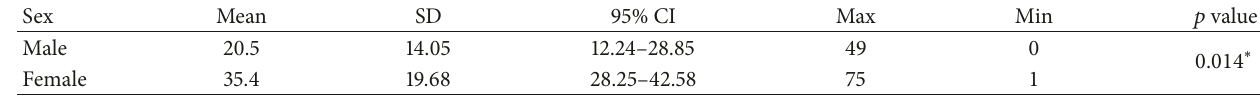
Table 2: Pain intensity scored on a VAS (0–100) for males and females analyzed with a 𝑡 -test. Sex